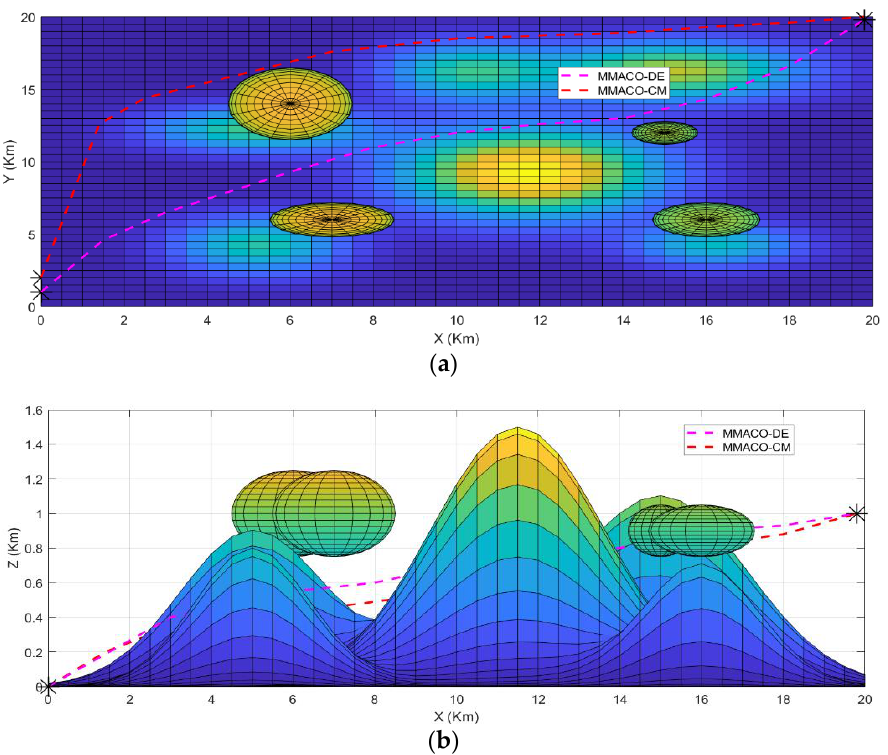
Figure 5. ( a , b ) Case 2; 2D path followed by UAV1(MMACO-DE) and UAV2 (MMACO-CM) to the target (*).